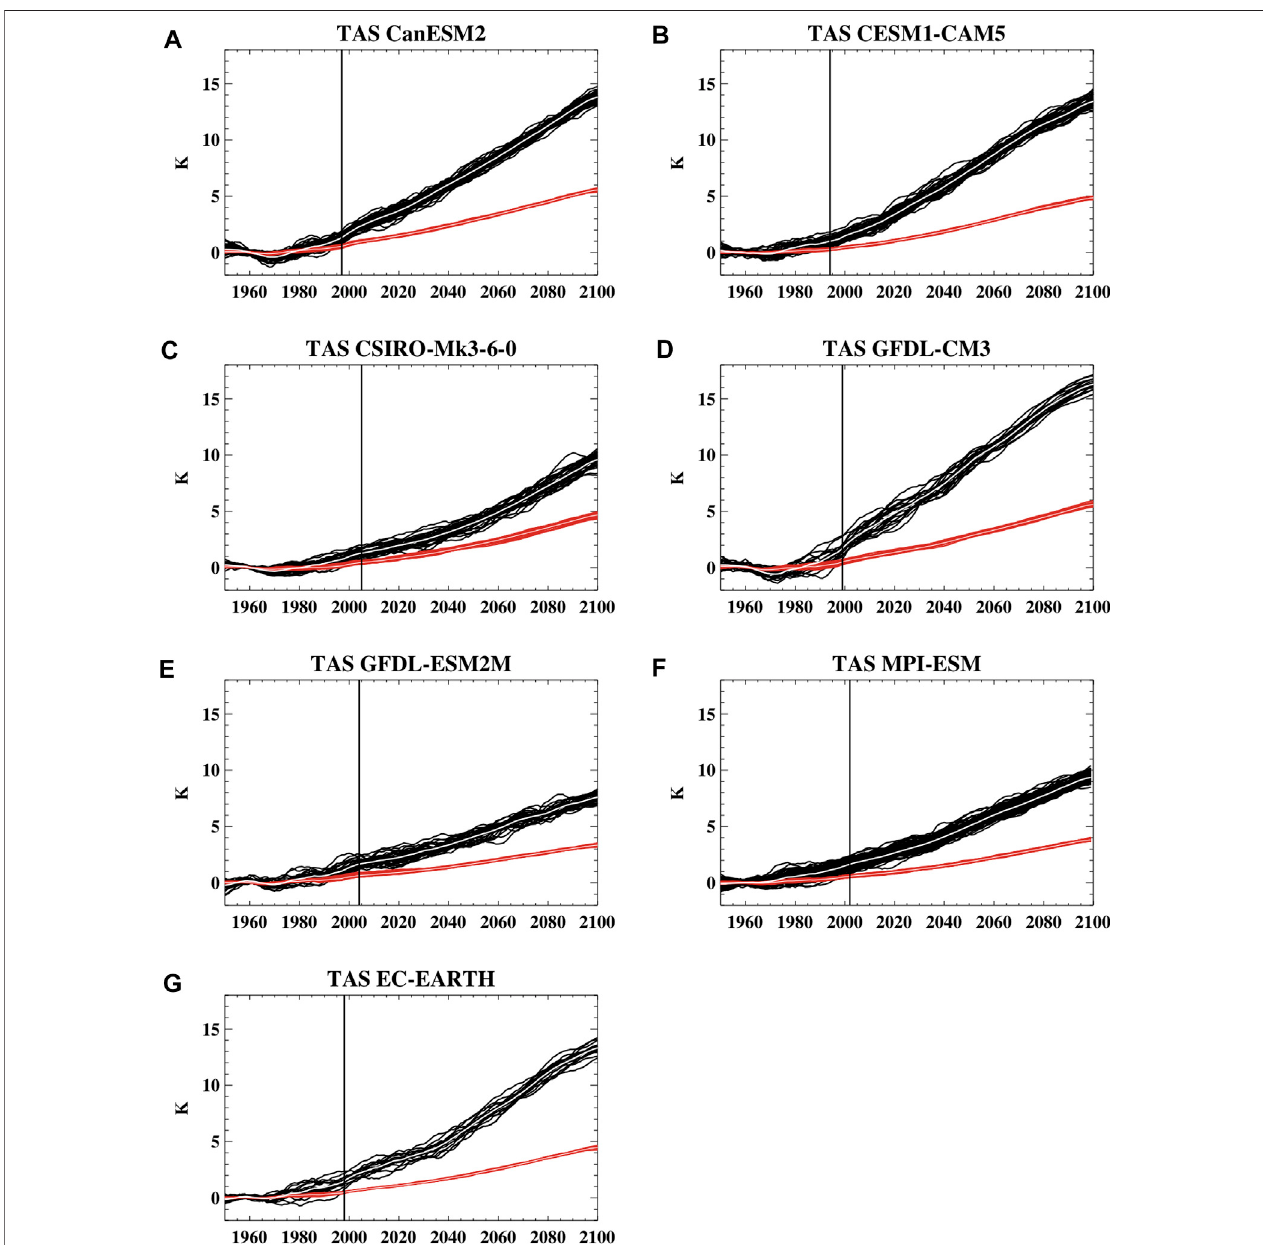
FIGURE 4 | Timeseries of decadal running mean surface air temperature change relative to the reference period for the 70 – 90N average in black and the globe averageinredforthedifferentmodelsincluding (A) CanESM2, (B) CESM1-CAM5, (C) CSIRO-Mk-3-6-0, (D) GFDL-CM3, (E) GFDL-ESM2M, (F) MPI-ESM,and (G) EC- EARTH. The ToE of an ampli fi ed Arctic warming signal is indicated by the vertical